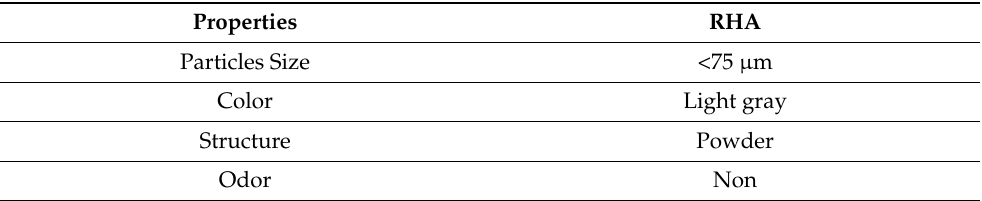
Table 4. Physical properties of RHA after grinding. Properties RHA Particles Size <75 µ m Color Light gray